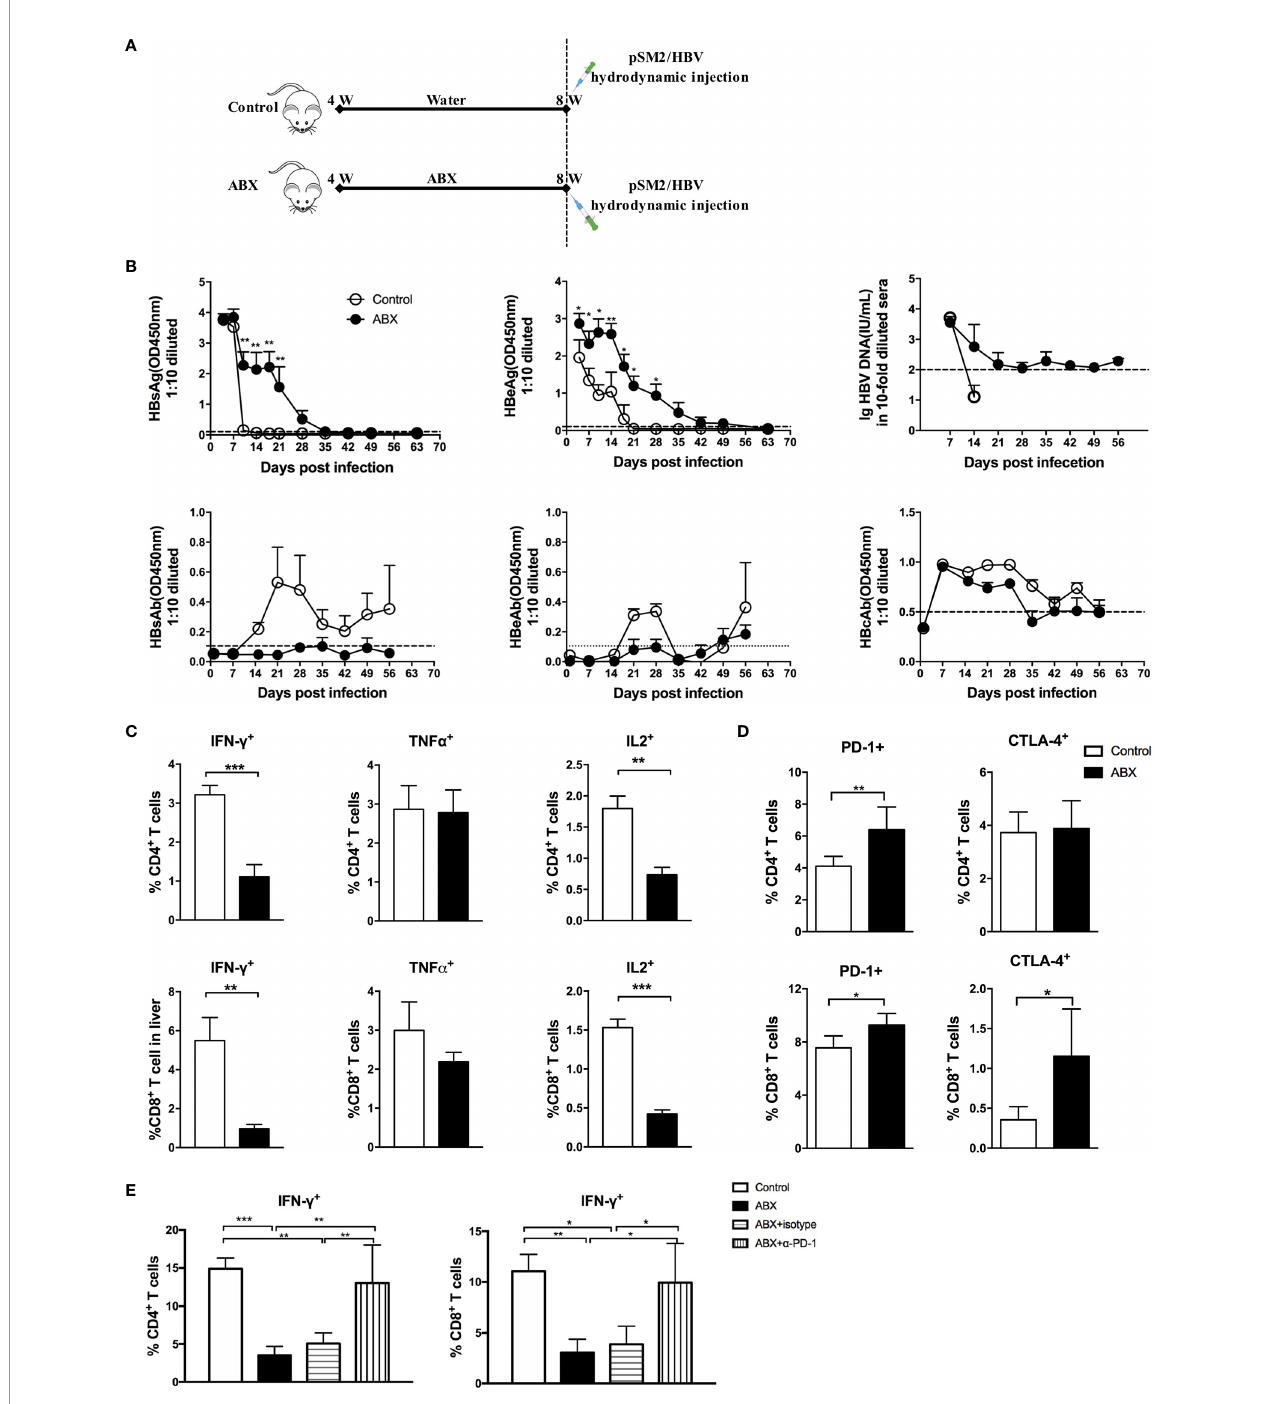
FIGURE 6 | Gut microbiota depletion impaired antiviral immune response and prolonged HBV infection. (A) Schedule of the experiment. Mice were fed with water or ABX for 4 weeks and then hydrodynamically injected with pSM2/HBV. (B) HBsAg, HBeAg, HBsAb, HBeAb, HBcAb, and HBV DNA levels in sera were monitored at the indicated times. HBV DNA can ’ t be detected after 14 days in control group and no data was shown. The cutoff values are shown as dotted lines. Mice were euthanized on day 12 after HBV infection; intrahepatic lymphocytes were stimulated with HBV core epitope and anti-CD28. The expression of intracellular cytokines (C) , immune checkpoint molecules PD-1 and CTLA-4 (D) were analyzed. (E) After blocking with a -PD-1, the expression of IFN- g in T cells was analyzed. n=10/ group, *P < 0.05, **P < 0.01, ***P <